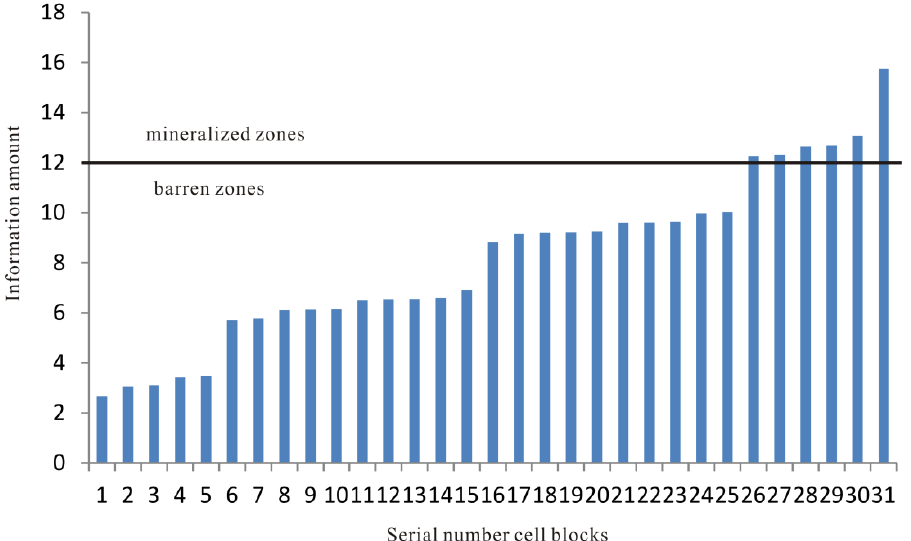
Figure 10. Histogram of metallogenic information amount showing the mineralized zones and the barren zone in the Sanshandao fault.